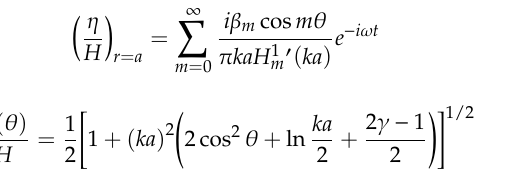
Figure 17. Comparison of numerically simulated run-up height around the mono-pile with the measured data.